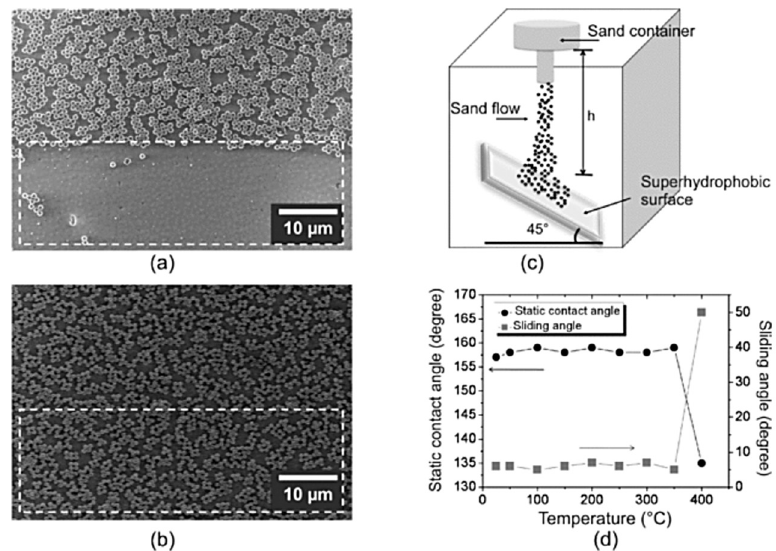
Figure 8. SEM images of superhydrophobic surfaces that were partially exposed to double sided tape (white boxes indicate the exposed areas). ( a ) If the particles stick to the surface by van der Waals interaction only, they can easily be removed; ( b ) Particles cannot be removed by double sided tape after binding them chemically to the surface by silica bridges; ( c ) Sketch of the setup used to determine the stability of the surface against sand impact; ( d ) Static contact angle and sliding angle measured after annealing the samples for 10 h at different temperatures. The surface remains superhydrophobic until annealing at 350 °C [34].